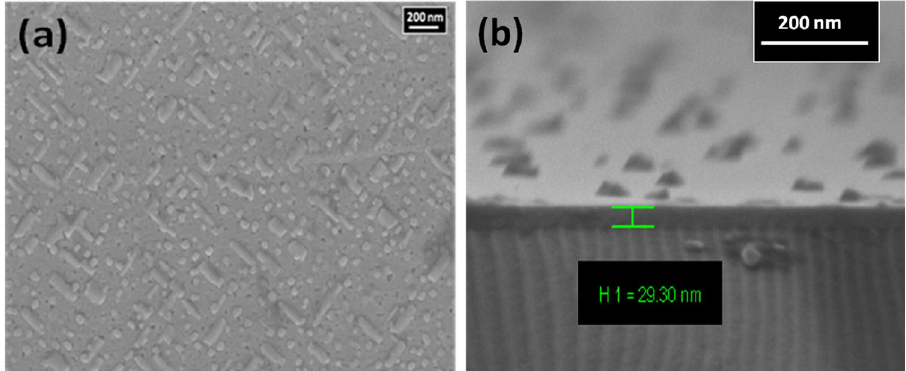
Figure 2. ( a ) Plan view SEM of PSMO/PCMO/STO heterostructure showing the crossed rod-shaped morphology; ( b ) Cross-sectional SEM of the heterostructure illustrating the total thickness of the heterostructure to be 30